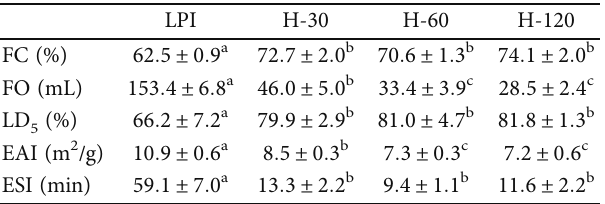
Table 3: Functional properties of LPI and its hydrolysates (H-30, H-60, and H-120).